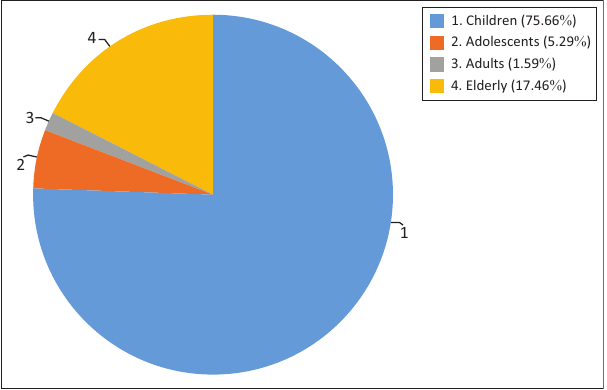
FIGURE 1: Respondents’ perceptions of the category of people most sensitive to radiation ( n = 189).